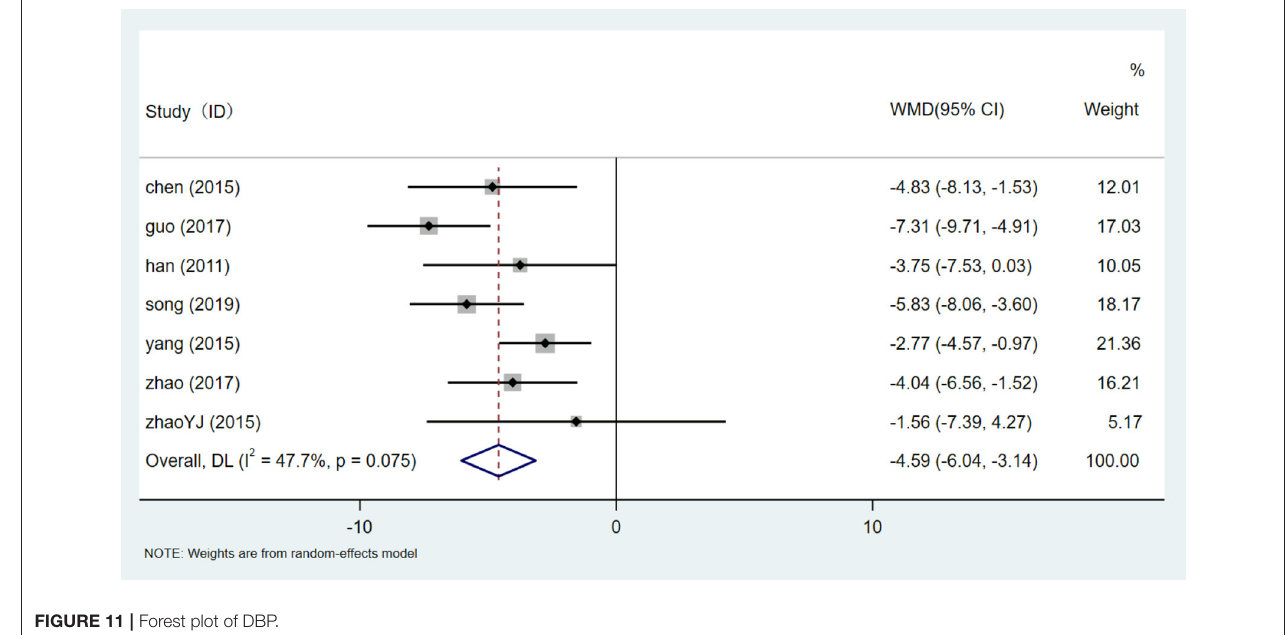
FIGURE 11 | Forest plot of DBP.